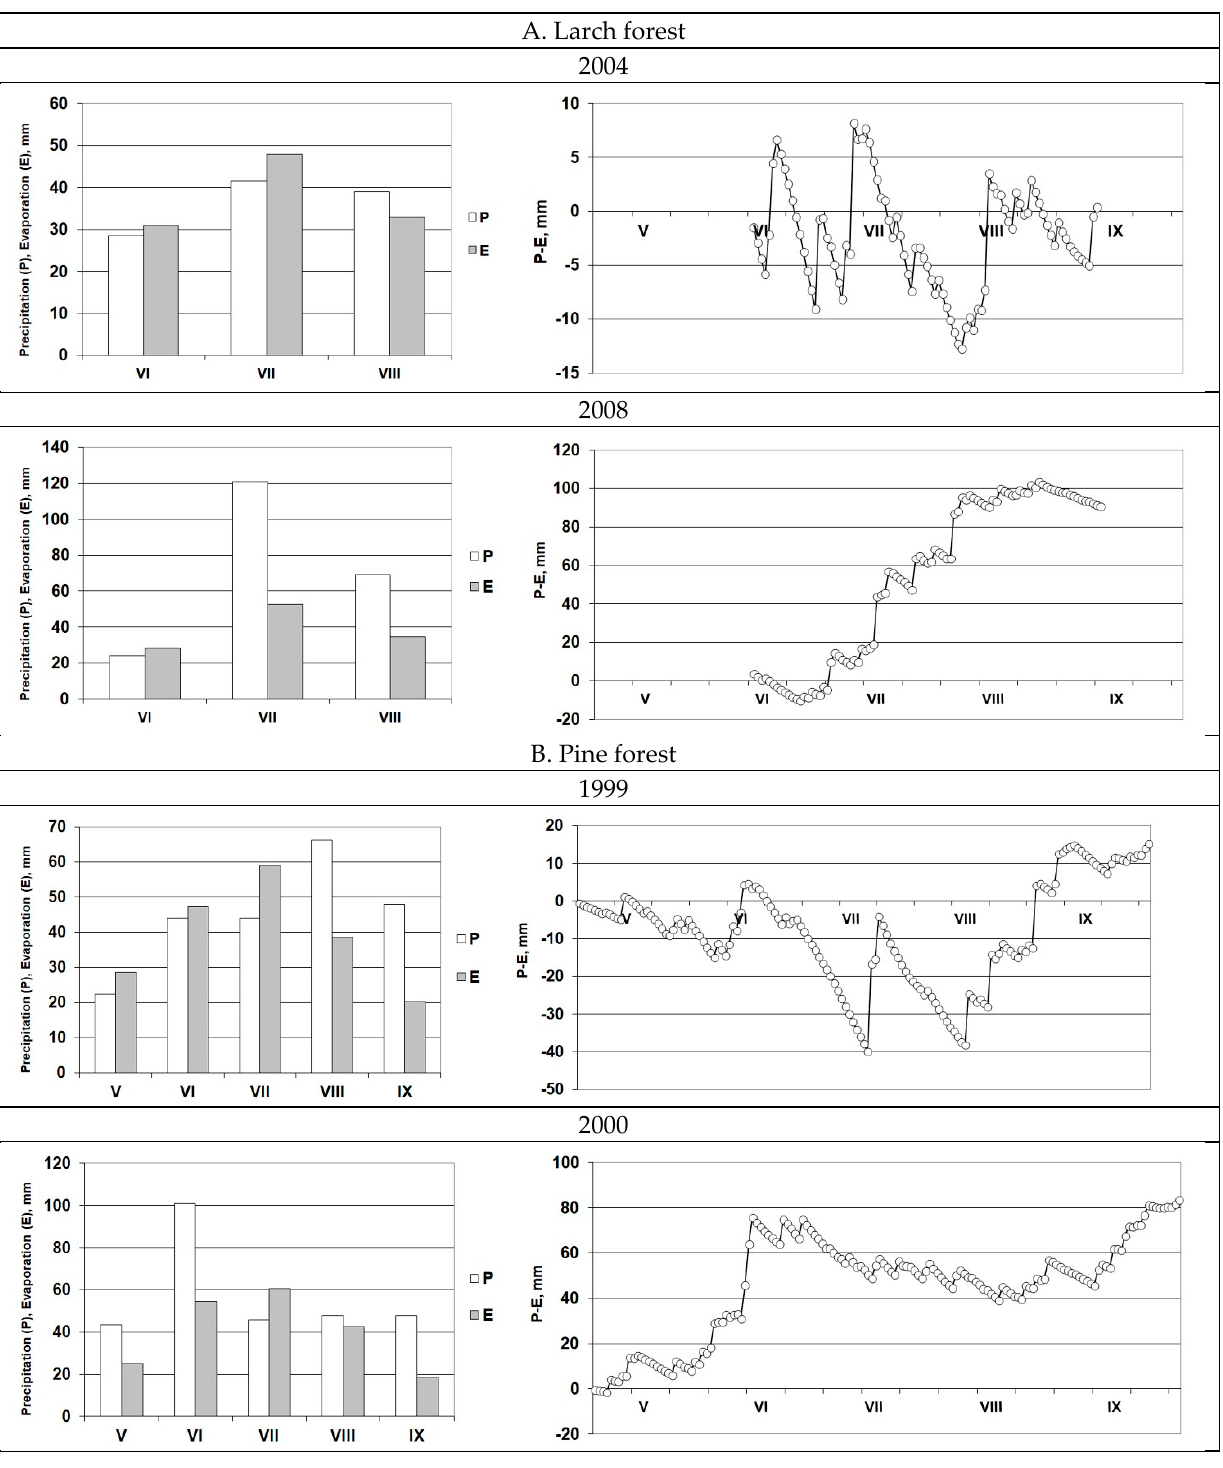
Figure 5. Monthly precipitation (P) and evaporation (E) ( left ) and cumulative water balance (P–E) for the growing seasons ( right ) in the dry year (2004) and in the wet year (2008) in the Gmelin larch and (1999) and (2000) respectively in the Scots pine ecosystems.